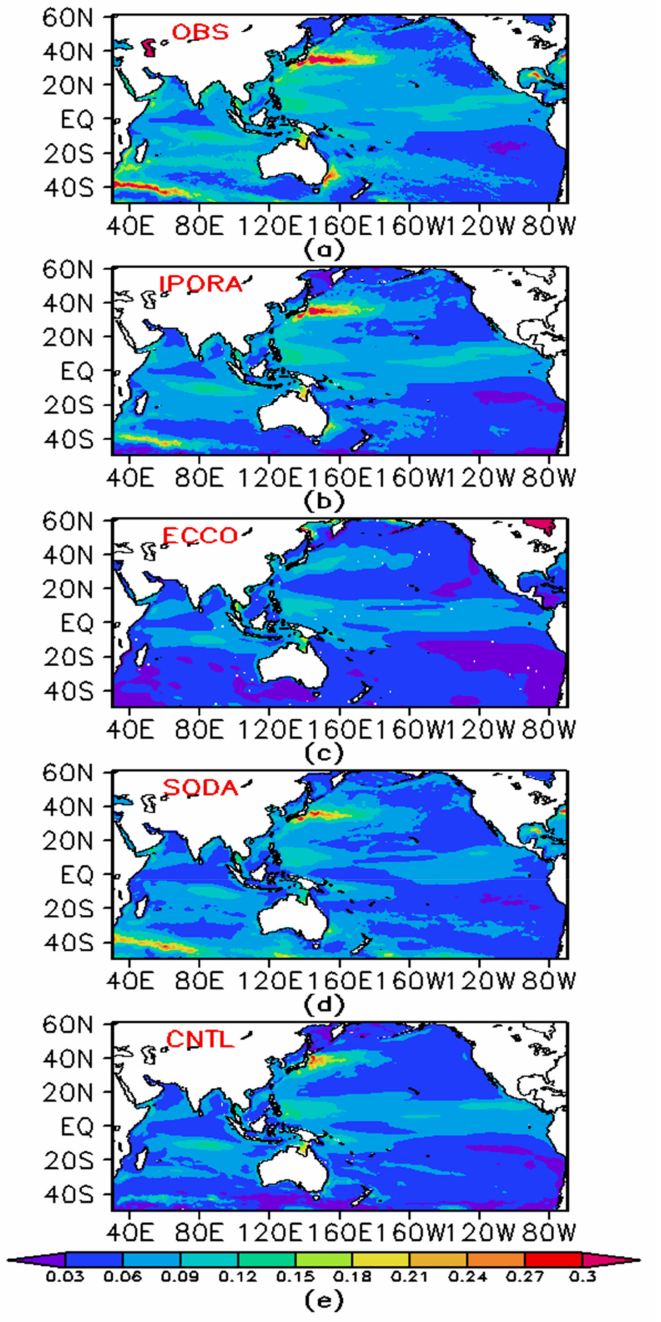
Figure 7. The standard variance of SLA (units: m) during the period of 1993–2020 in the Indian and Pacific oceans from ( a ) observations, ( b ) IPORA, ( c ) ECCO, ( d ) SODA, and ( e )